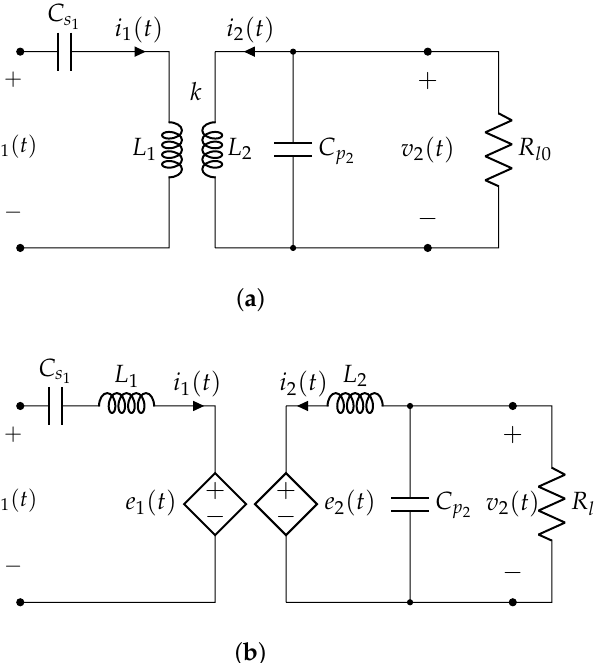
Figure 3. Equivalent circuits of the resonant inductive link where the inductive coupling is repre- sented by means of ( a ) two coupled inductors and ( b ) two decoupled inductors with series controlled voltage sources.